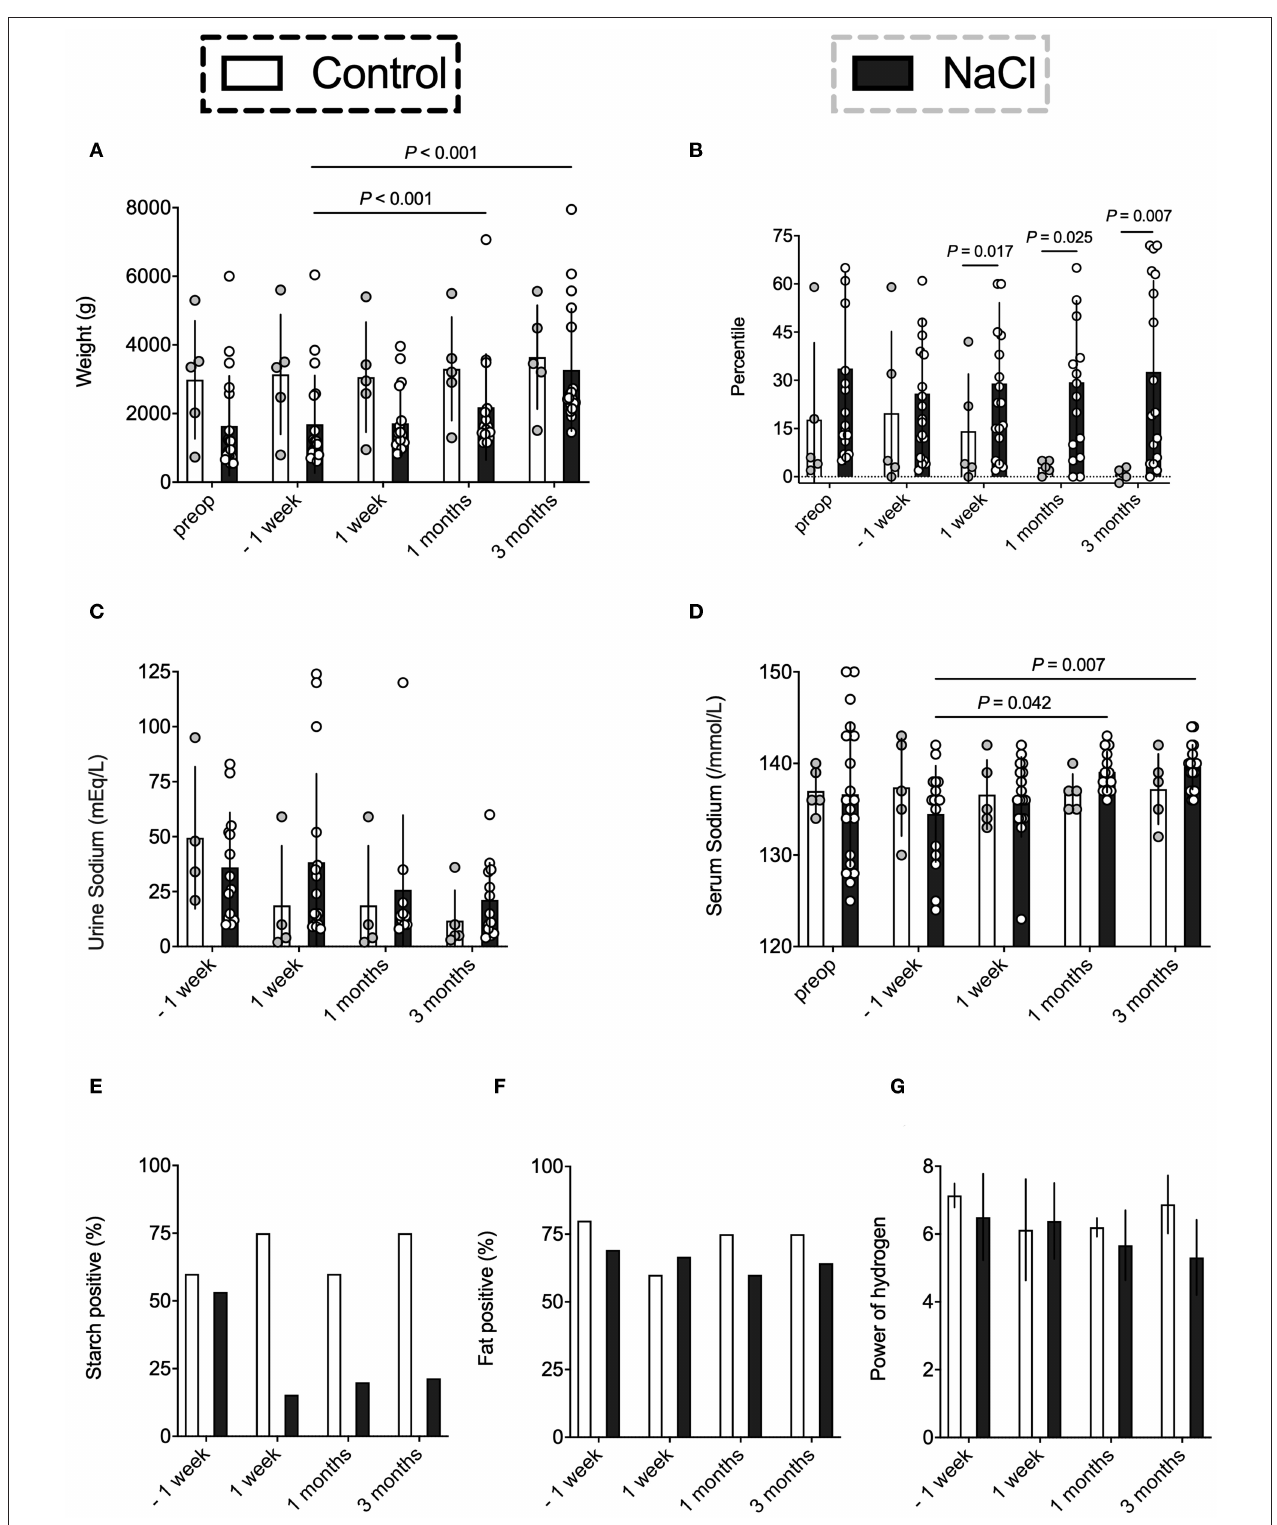
FIGURE 1 | Evaluation of the effect of NaCl on weight gain, sodium levels, and resorptive bowel capacity. Data were analyzed on five occasions: before stoma formation (preop), 1 week before intervention* ( − 1 week), and on three occasions after intervention* (1 week, 1 month, 3 months). *intervention = NaCl vs. none. (A,B) The NaCl group revealed an improved weight gain after supplementation as compared to the control group who showed steadily decreasing Fenton percentiles.